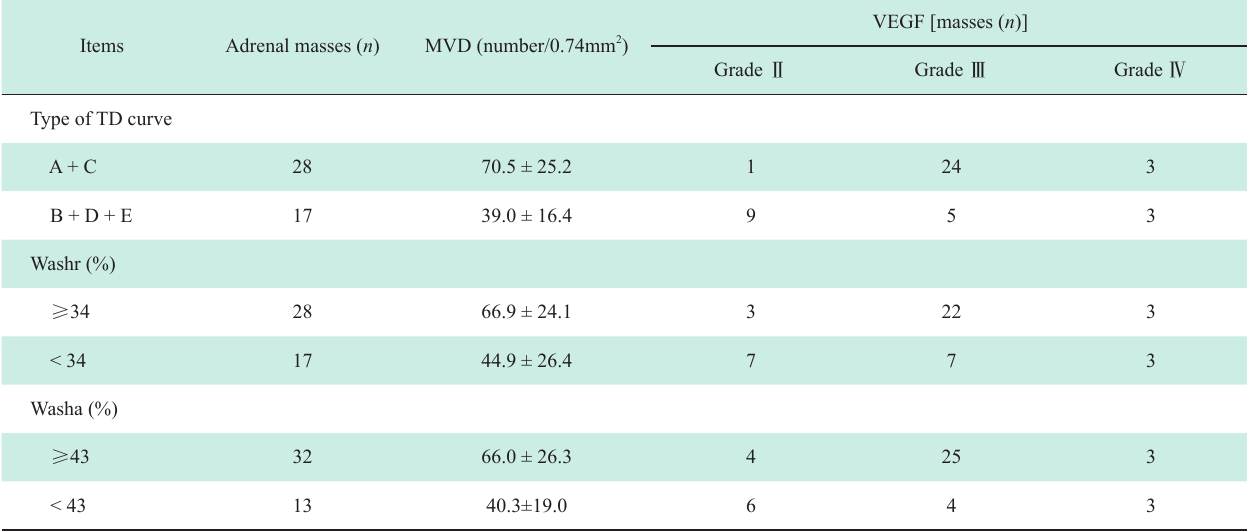
Table 2 Correlation between DET-CT findings and MVD and VEGF in adrenal